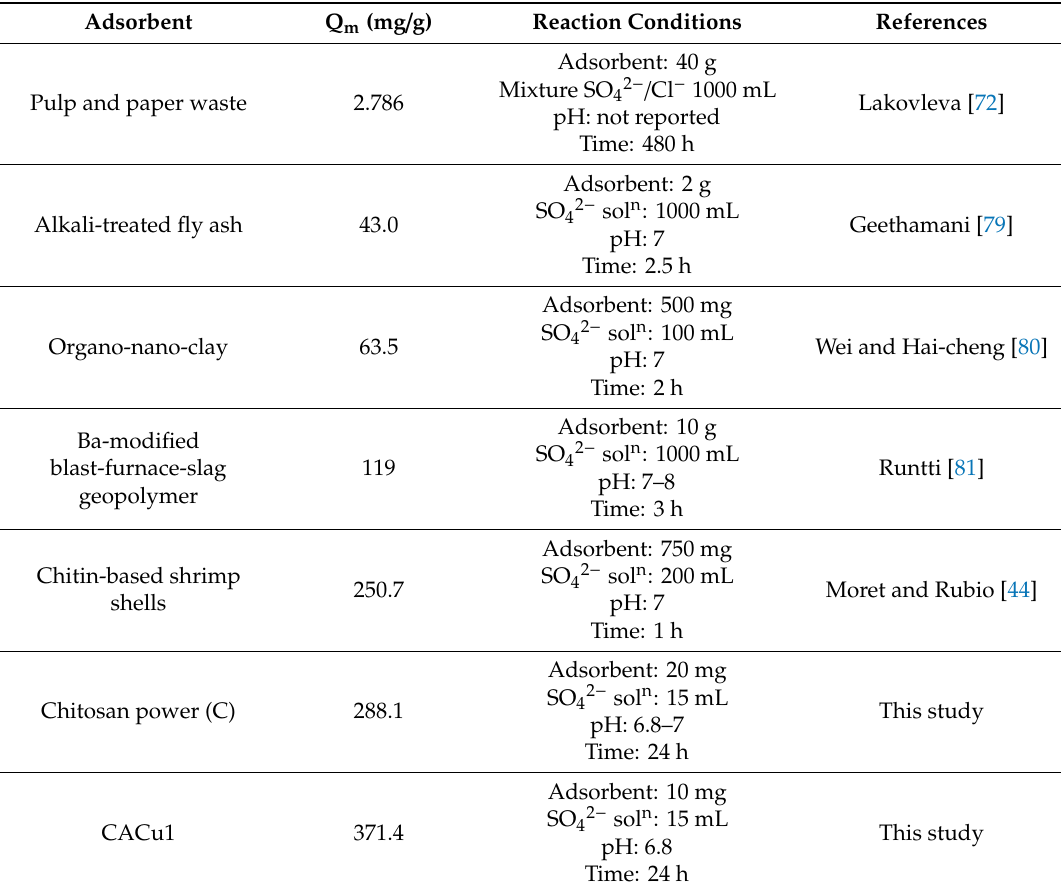
anions from aqueous